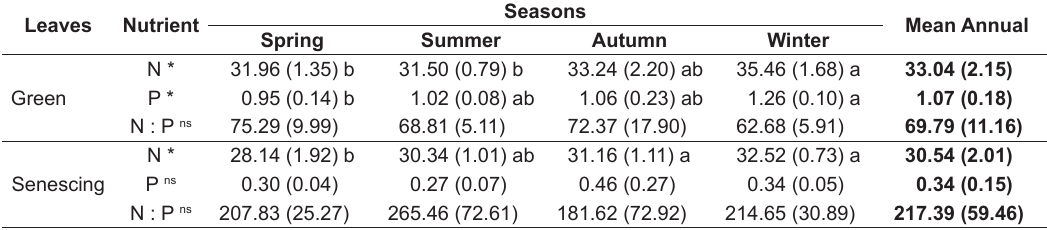
Table 1. N and P mean content (mg DW g –1 ) and N : P in the different leaves of the aquatic macrophyte T. domin- gensis in four different seasons (Spring, Summer, Autumn and Winter) and Mean Annual. The standard deviation is in parenthesis. Identical letters indicate groups of means with no statistically significant differences at the 95 % confidence level.